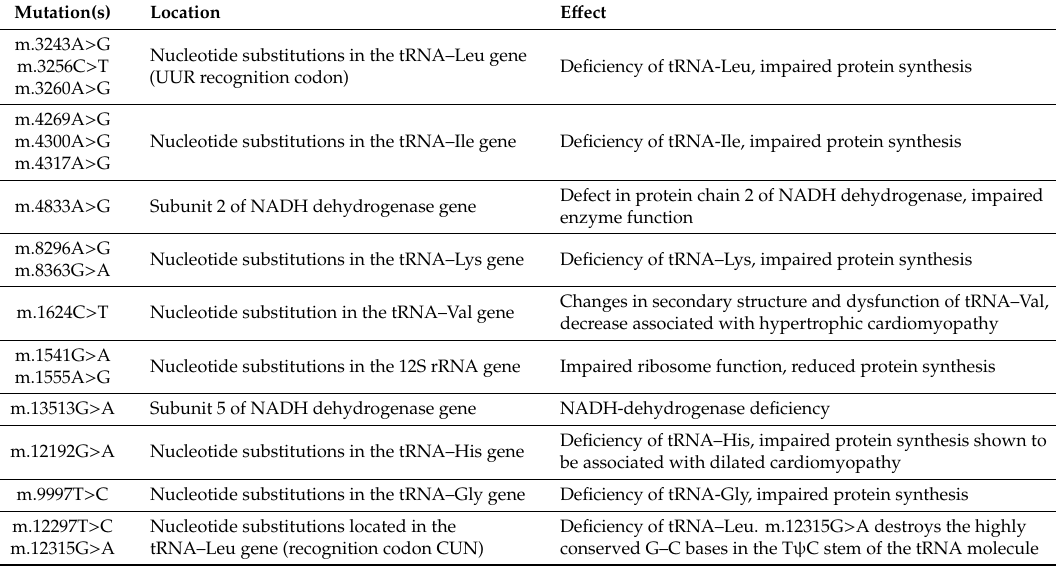
Table 2. Mitochondrial mutations associated with cardiovascular disease (CVD) in